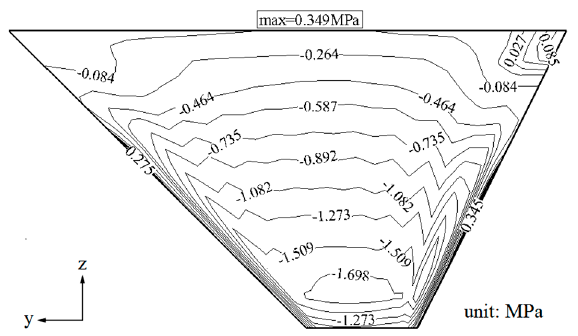
Appl. Sci. 2019 , 9 , x FOR PEER REVIEW Figure 19. Major principal stress contours of SACC ( h = 200 m). Figure 19. Major principal stress contours of SACC ( h =200 m) . Figure 19. Major principal stress contours of SACC ( h =200 m) .